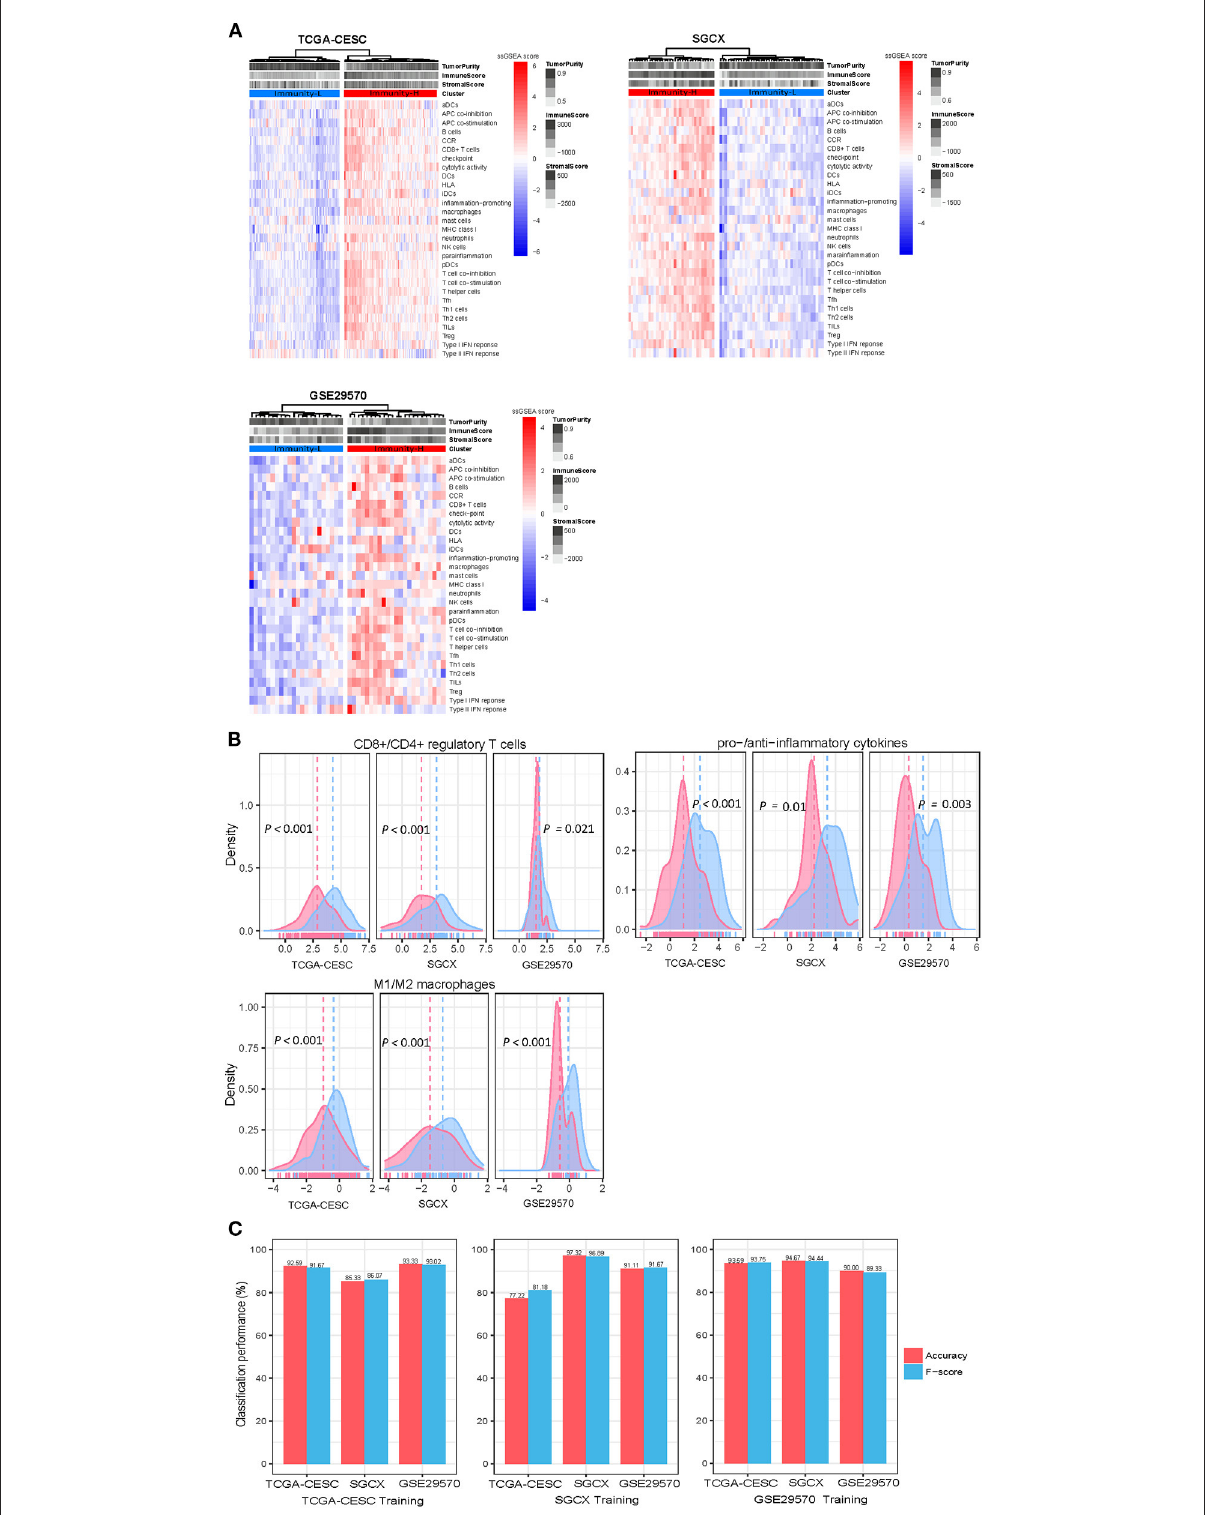
FIGURE1 Clustering analysis identifies two immune subtypes of HPV + cervical cancer. (A) Based on the enrichment levels of 29 immune signatures, hierarchical clustering identifies two immune subtypes: Immunity-H and Immunity-L, which have high and low immunity, respectively, consistently in three datasets. (B) Immunity-H has significantly higher ratios of immunostimulatory to immunosuppressive signatures than Immunity-L. The two-tailed Student’s t -test P -values are shown. (C) Prediction of the immune subtypes of HPV + cervical cancer by Random Forest based on the enrichment scores of 29 immune signatures. The 10-fold cross-validation results in the training set and prediction results in the other test sets are